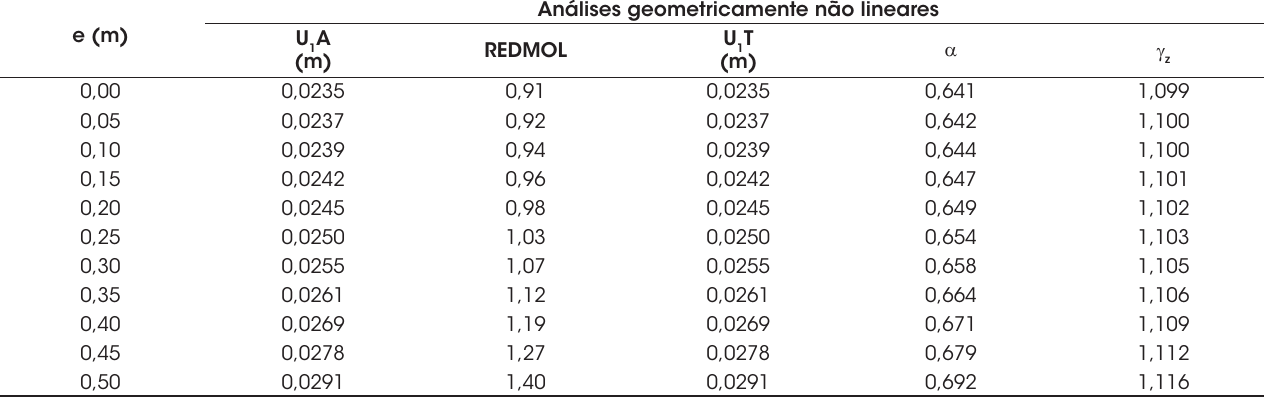
Tabela 15 os valores de REDMOL, α e γ MP3DSL6 com simulações